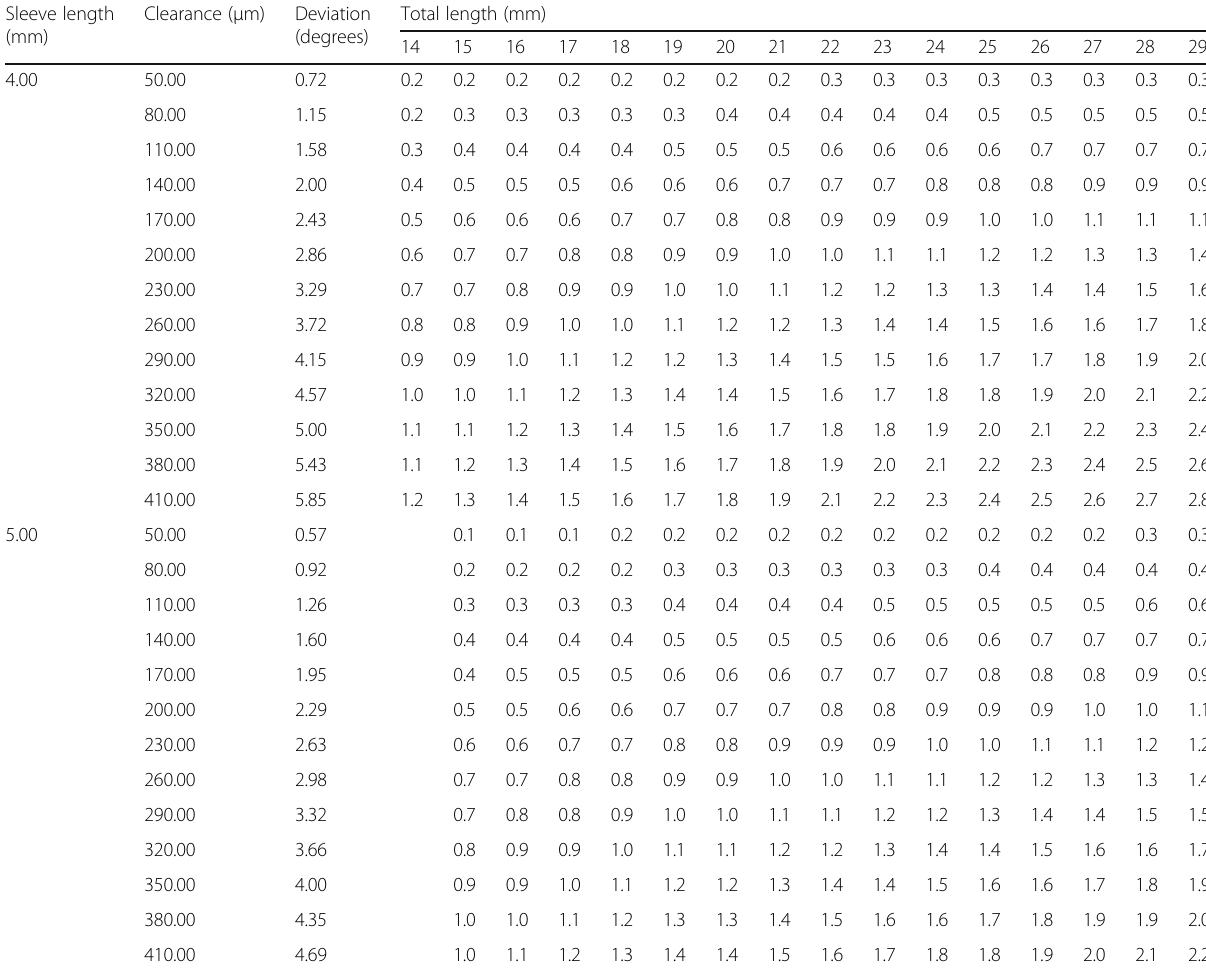
Table 2 Error at the apex (mm) and deviation of implant axis (°) for sleeve lengths 4 and 5